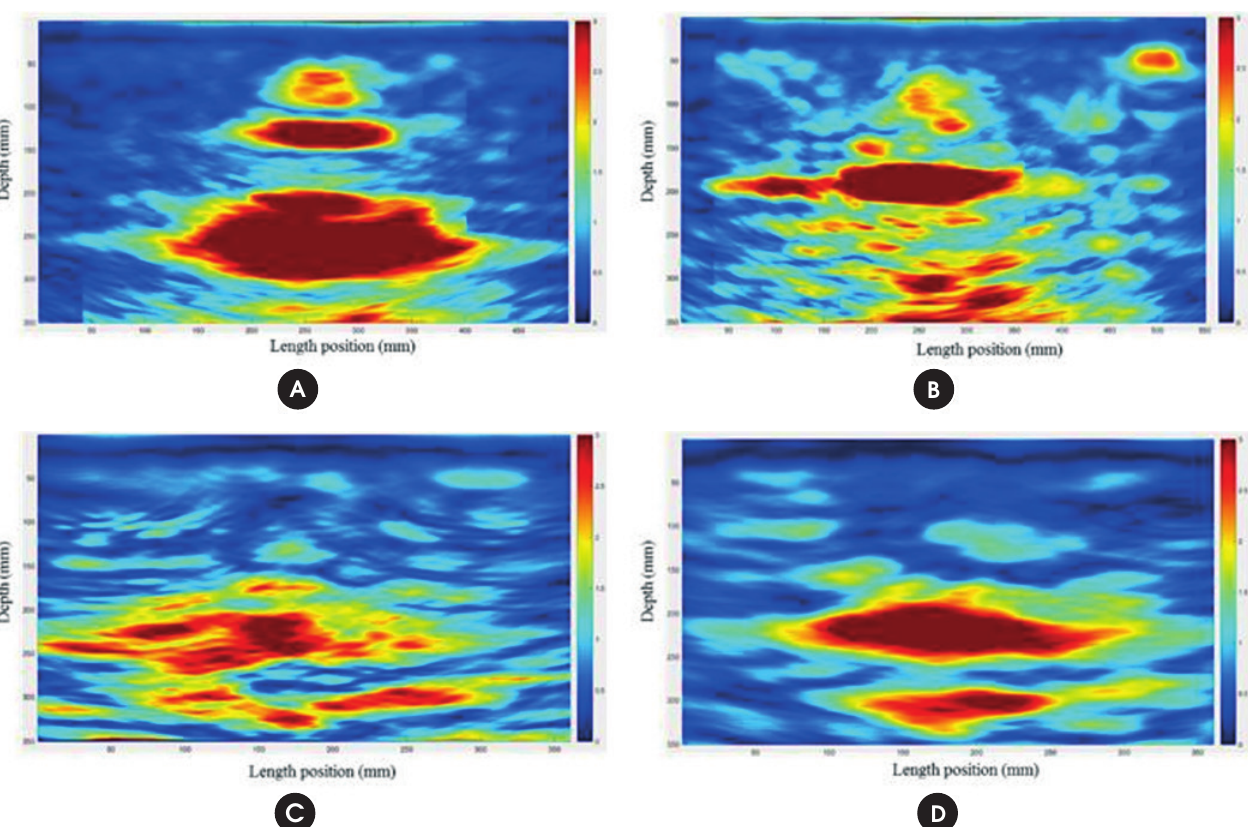
Reconstruction of distress locations presenting (a) and (b) cracks; and (c) and (d)